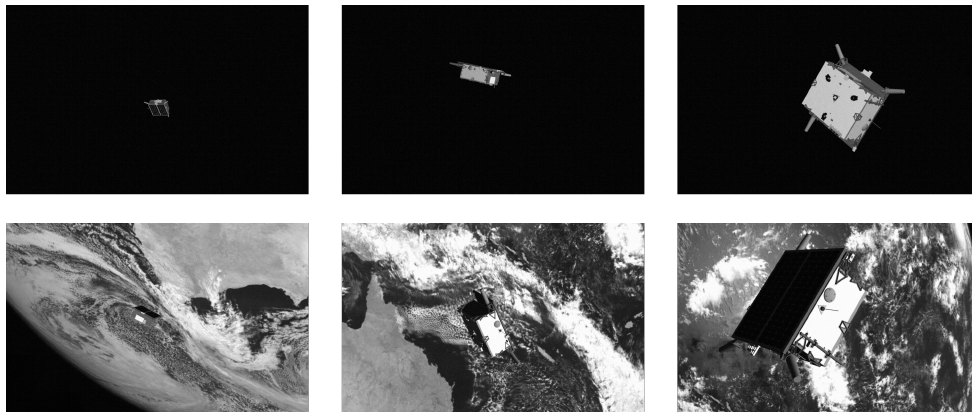
Figure 4. Sample images from the SPEED.